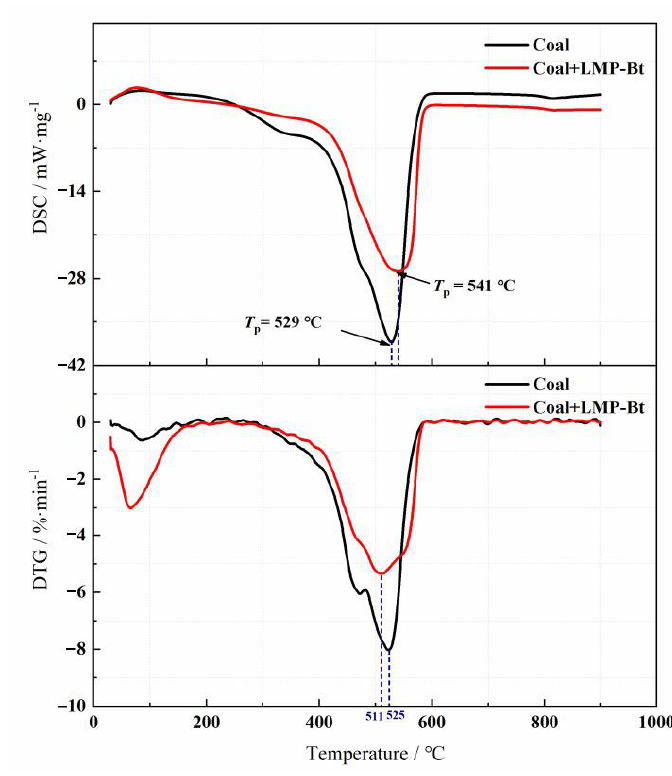
Figure 13. DTG-DSC curves of the coal and coal + LMP-Bt samples.